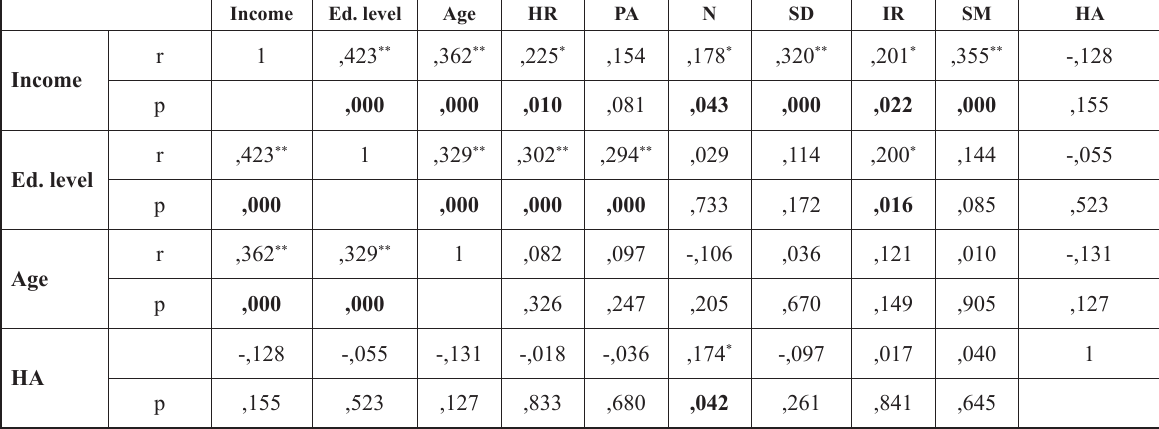
Table 4. Correlation between scale scores and demographic